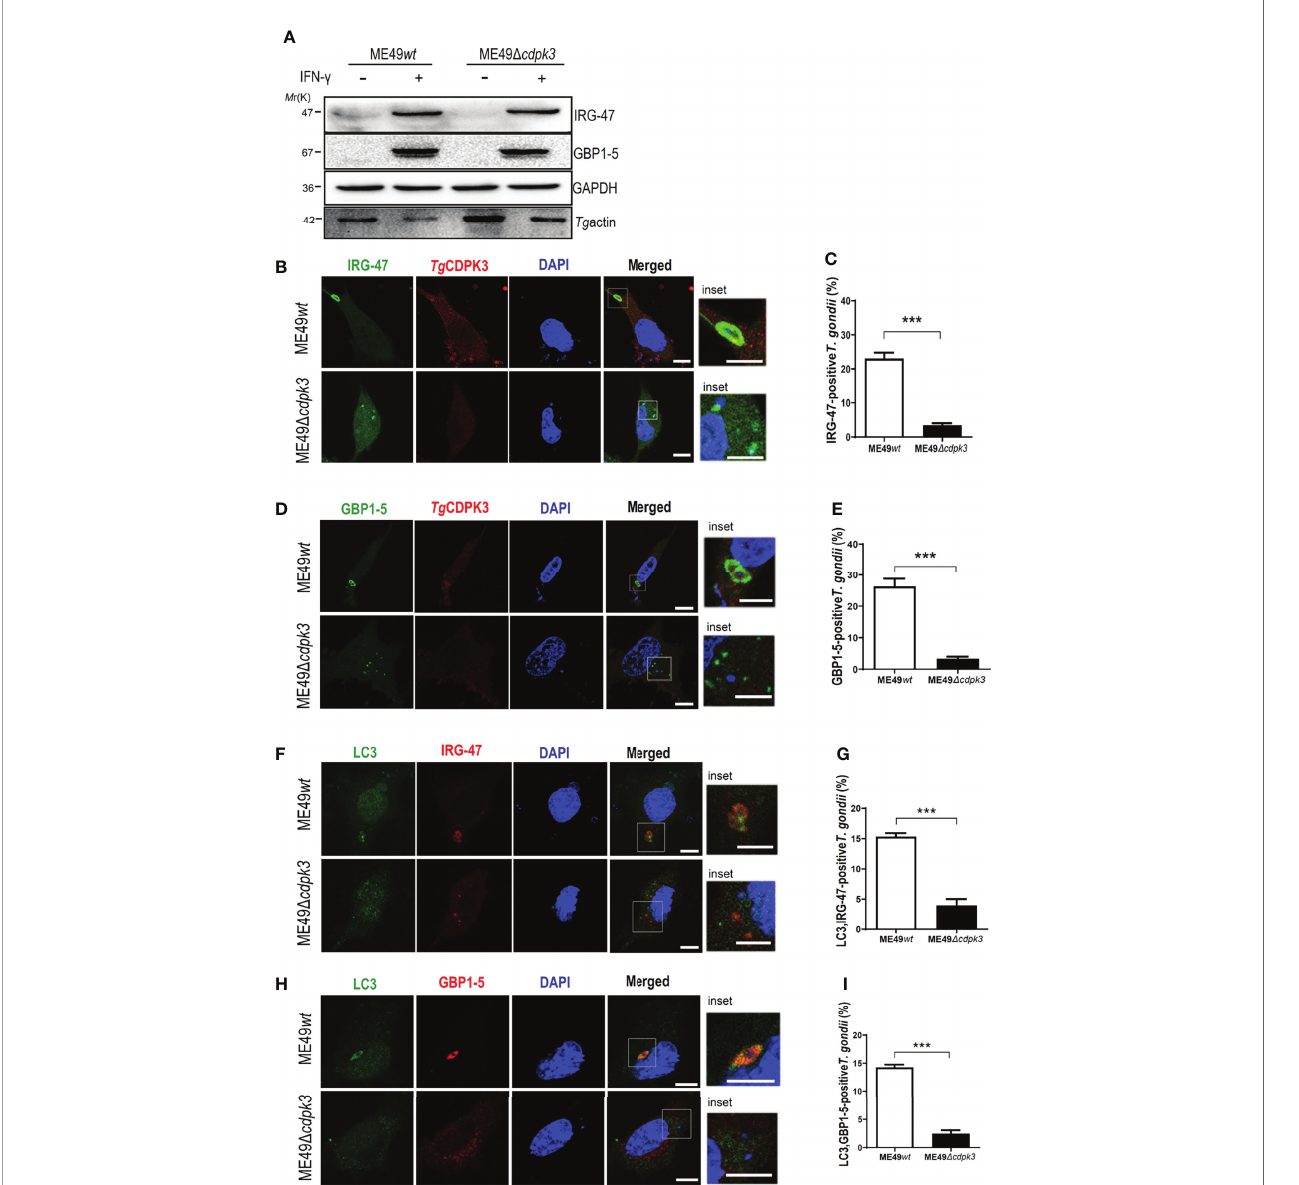
FIGURE 6 | Tg CDPK3 plays a critical role in IFN- g induced IRG-47 and GBP1-5 targeting PV membrane. (A) Macrophages (pre-treated with 100 U/ml IFN- g for 24 h) infected ME49 wt or ME49 D cdpk3 parasites were lysed. The lysates were detected by western blot with the indicated antibody. GAPDH was used as a loading control. (B – E) Cells (pre -treated with 100U/ml IFN- g for 24 h) were infected with ME49 wt or ME49 D cdpk3 parasites (moi =3), fi xed at 4-6 h post-infection, and incubated with rabbit anti-CDPK3 antibody (red), mouse anti-IRG-47 antibody (green) or mouse anti-GBP1-5 antibody (green), and DAPI (blue). (Scale bar:5 m m) (F – I) Cells (pretreated with 100 U/ml IFN- g for 24 hours) infected ME49 wt or ME49 D cdpk3 parasites (moi =3), fi xed at 4-6 h post-infection, and incubated with rabbit anti – LC3II (green), mouse anti-IRG-47(red) or mouse anti-GBP1-5(red), and DAPI (blue). (Scale bar: 5 m m) Data are mean ± SD of triplicates. Statistical differences are represented by ***p < 0.001 (n = 3 each